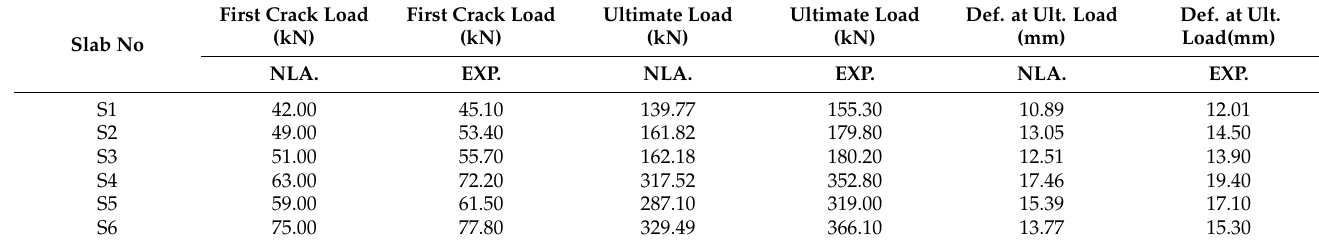
Table 13. Experimental and numerical results.